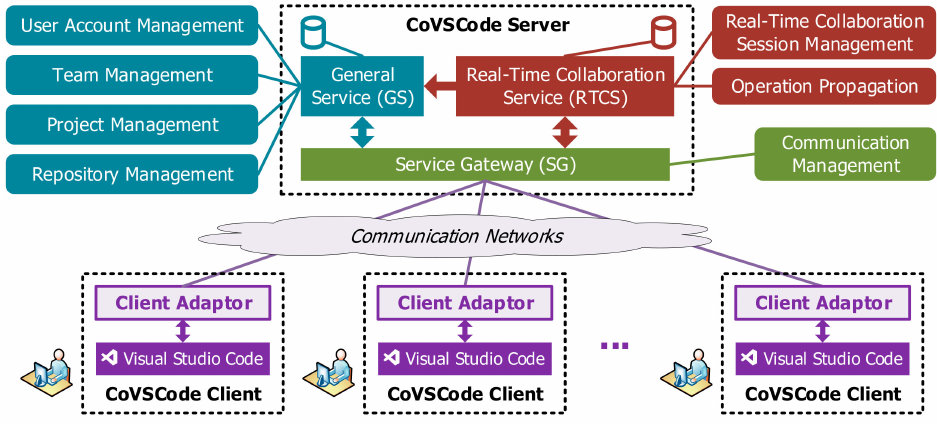
Figure 2. The CoVSCode system